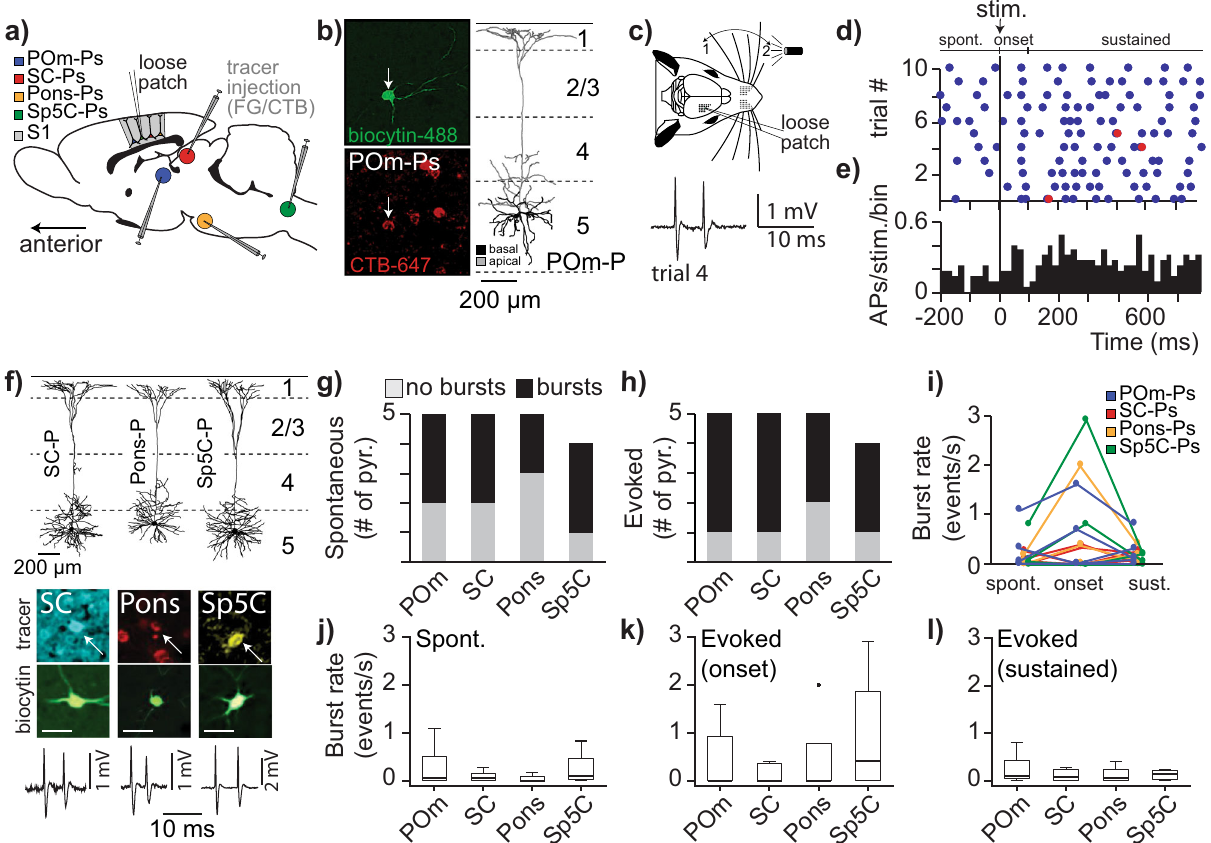
Fig. 7 High-frequency bursting upon whisker stimulation is observed in L5tts projecting to different subcortical targets. a Injections of retrograde tracers into the major subcortical targets of L5tts in rat primary somatosensory cortex (S1), allowing back-labeling and projection-speci fi c identi fi cation. Panel adapted from ref. 11 . b Loose-patch recording and biocytin labeling leads to identi fi cation of cell-type-speci fi c morphology and projection target. Here, biocytin labeling of exemplary neuron in L5, after retrograde tracer injections into the SC (FG), Pons (CTB-594), and POm (CTB-647). Slices were stained with Alexa-405 and Alexa-488 to reveal retrogradely and biocytin-labeled neurons (white arrow), respectively. Right panel: 3D morphological reconstruction of the exemplary L5tt. c Cartoon of recording con fi guration with loose-patch, single-unit recording in primary somatosensory cortex in combination with passive, multi-whisker stimulation (air-puff). Example voltage trace illustrates a stimulus-evoked high-frequency burst of the POm- projecting L5tt pyramid shown in Fig. 7b. d Raster plot with AP spiking aligned to consecutive touches. APs at instantaneous frequency of ≥ 100 Hz are indicated by red bullets. e Peri-stimulus-time-histogram (PSTH) aligned to touch start. f Examples of L5tt reconstructions projecting to different subcortical targets and high-frequency bursts (bottom trace) observed in these neurons. Scale bar biocytin- fi lled cell bodies: 50 μ m. g , h High-frequency bursts are observed during g spontaneous and h stimulus-evoked windows in L5tts with different project-targets (individual ratios not signi fi cant relative to general population, Chi-Square p > 0.05). i Burst rate for individual L5tt neurons across conditions with color code representing projecting target (legend in a ). j – l Fraction of supracritical burst events upon whisker stimulus is generalizable across L5tts with different projection targets (Kruskal – Wallis, p > 0.05) as shown for spontaneous spiking ( j ), the onset of evoked activity ( k ), and in the window representing sustained activity ( l ), respectively. Boxplots show median as central mark, the edges of the box the 25th and 75th percentiles, the whiskers extend to the most extreme data points, and the outliers are plotted